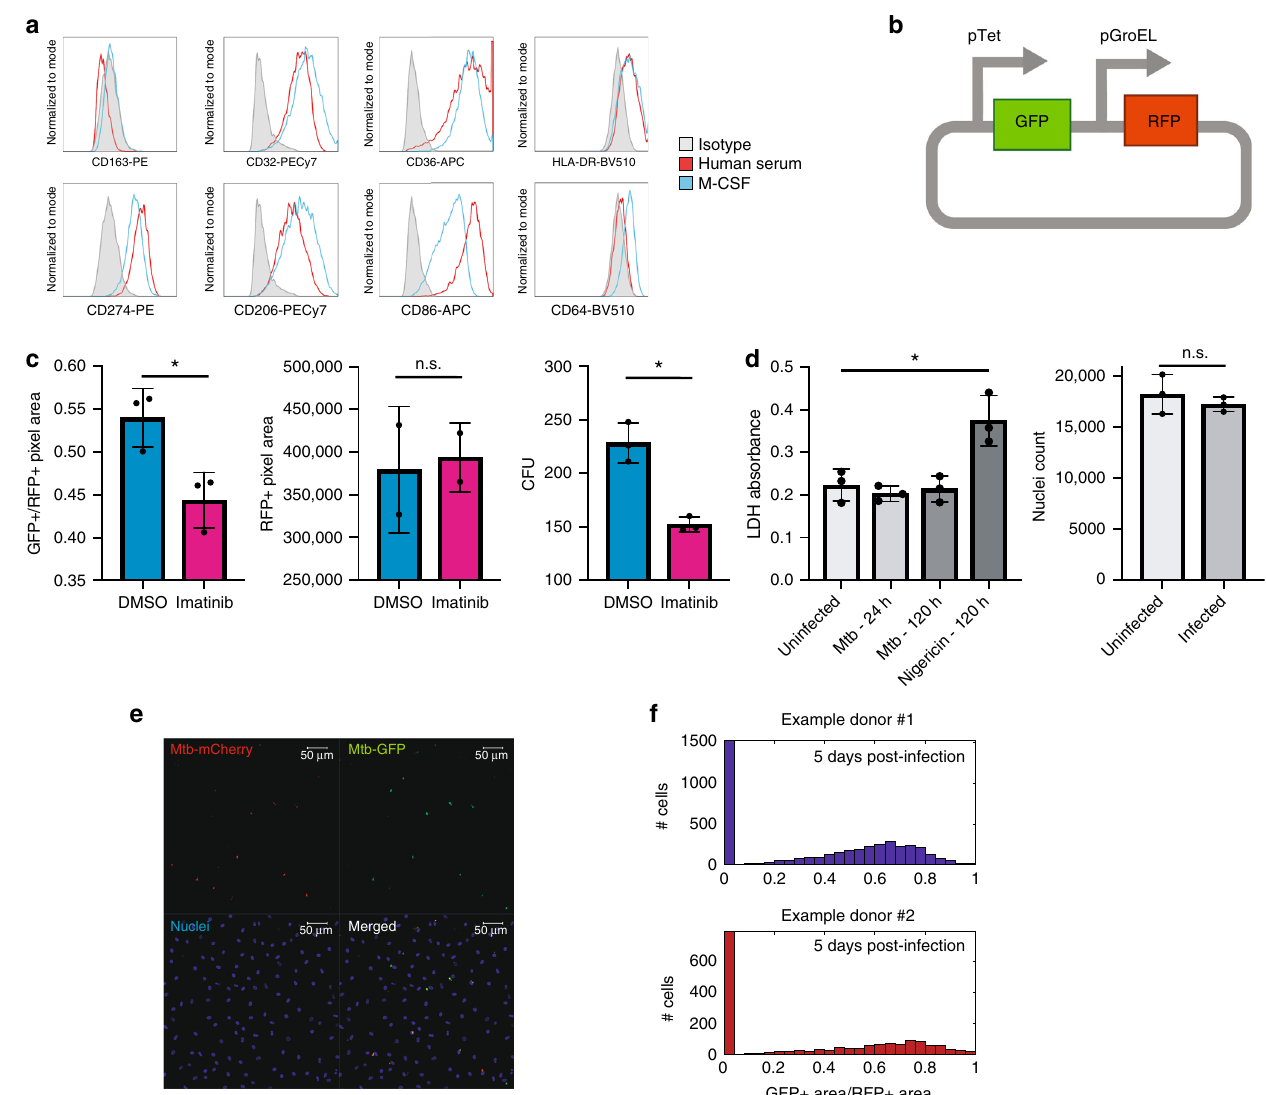
Fig. 1 Primary monocyte-derived macrophages have variable capacity to restrict Mtb. a Representative fl ow cytometry plot of surface expression of CD163, CD32, CD36, HLA-DR, CD274, CD206, CD86, CD64 on human serum or M-CSF-derived macrophages b Plasmid design for transcriptional live-dead reporter. c Quanti fi cation of bacterial viability (GFP + area/RFP + area) in macrophages stimulated with DMSO or imatinib. Comparisons made using a two-tailed t -test. d Quanti fi cation of macrophage viability by LDH release and nuclei counting following Mtb infection. Comparisons made using a